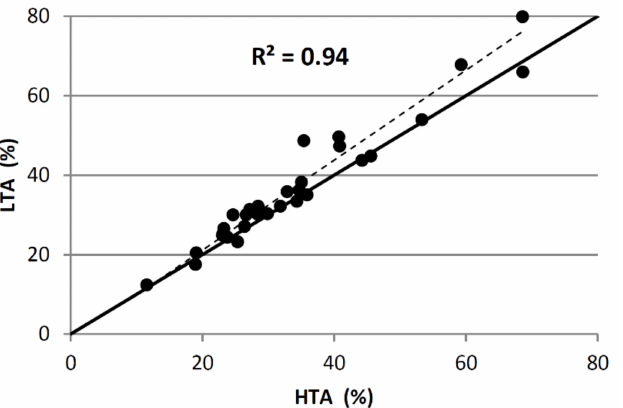
Figure 17. Comparison of HTA to LTA. LTA: low-temperature ash yields of coal samples. The diagonal line indicates equality and the dotted line is the trendline of LTA vs.